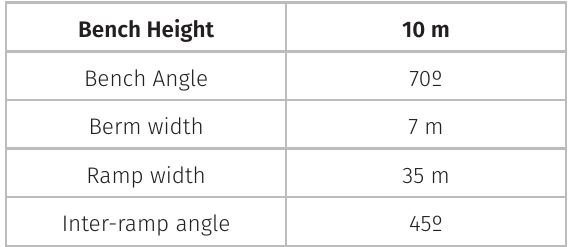
Table III. Actual designed slope